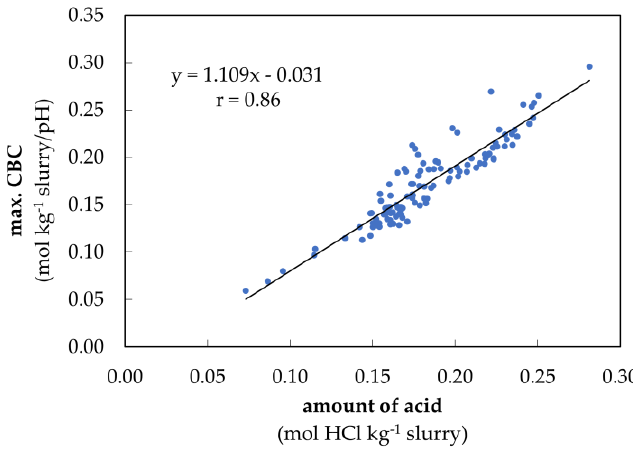
Figure 5. Maximum CBC during acidification in the HCO 3- buffer depending on the amount of acid from pH value 7.0 to 5.5 of the fattening pig, dairy cows and sow slurry (n = 115).